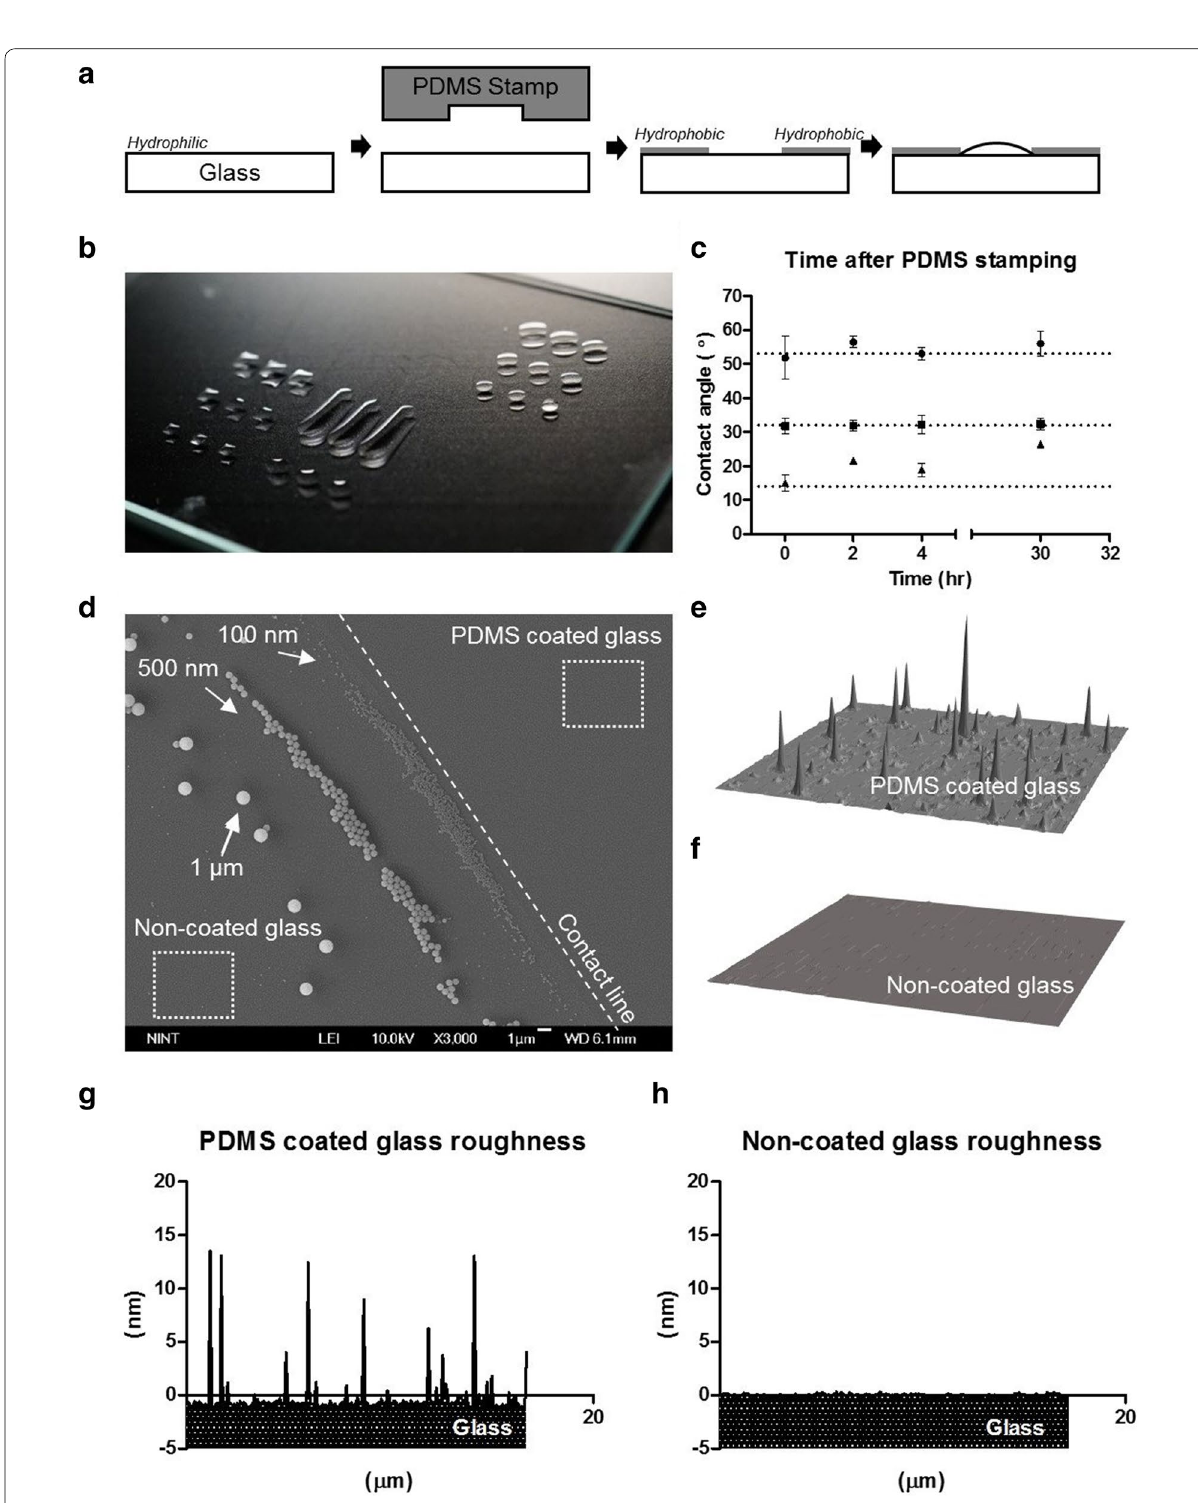
Fig. 2 a Schematic of PDMS-coated glass by PDMS stamp. b Image of patterned droplet on PDMS coated glass. c Contact angle of droplet vs. time after PDMS stamping. d SEM image of contact line of evaporated droplet with 100 nm, 500 nm, and 1 µm beads on PDMS-coated glass. AFM image of e PDMS coated area on glass and f non-coated glass. Surface roughness of g PDMS coated glass and h untreated